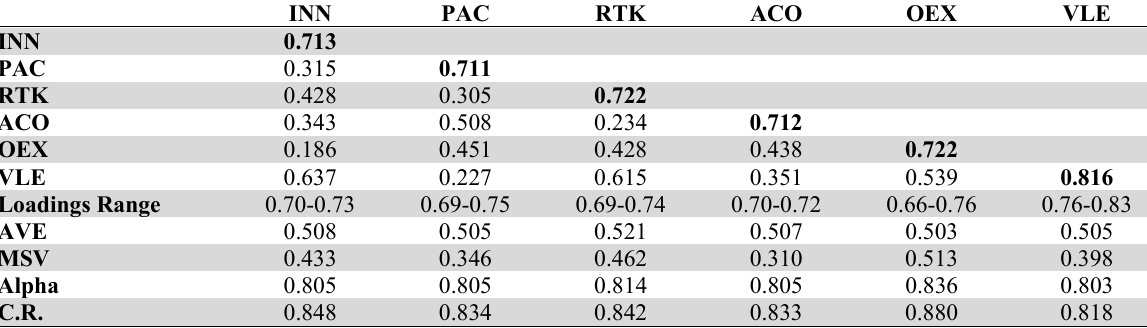
The results of testing instrument validity and reliability